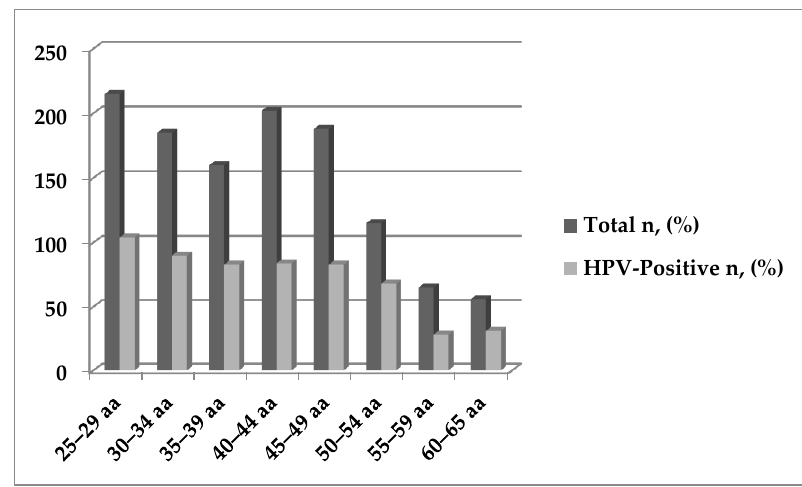
Figure 1. HPV-DNA positivity by age groups. The most frequent genotypes in multiple infections were HPV-31 and -66. A higher prevalence of single infections was found in individuals with a negative cytology (~68%), and in those classified as CIN1 and CIN3 (57% and 71%, respectively). Infections caused by more than one genotype were mainly found in CIN2 cases (>53%). median (IQR) period of 7 (8–9) months. Overall, most women registered a regression of lesion with a negative result (412/614; 67.1%), whereas 24.2% (149/614) and 3.6% (20/614) were classified as LSIL and HSIL, respectively.